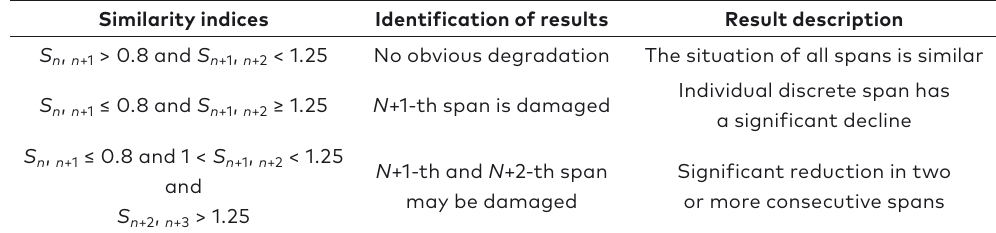
Table 3. Basis of damaged span